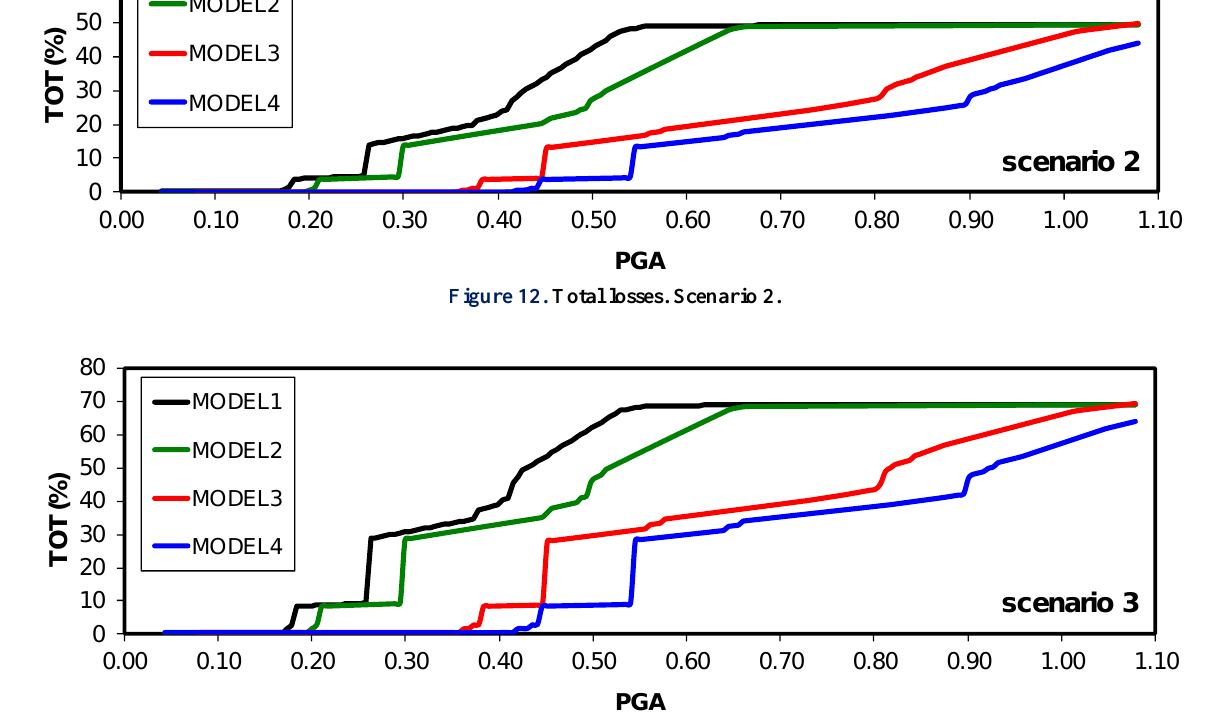
Figure 13. Total losses. Scenario